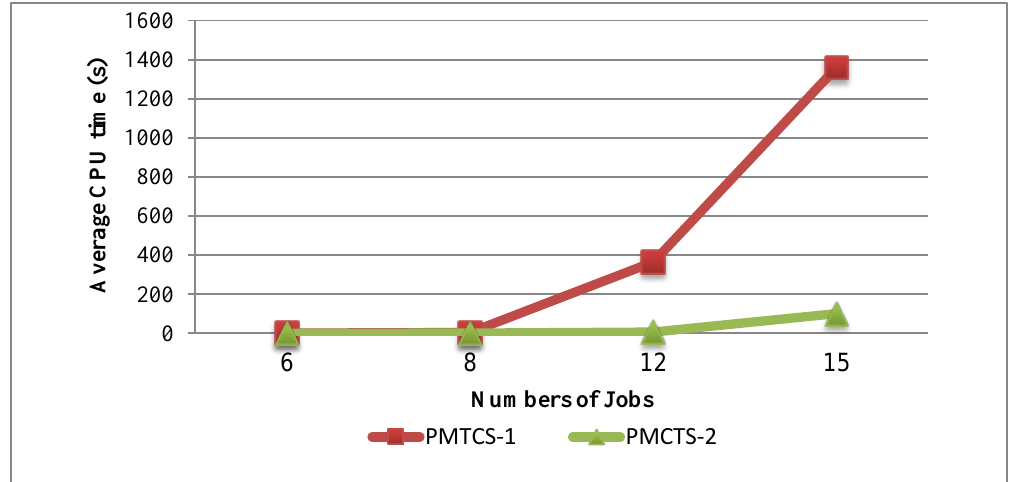
Fig. 3. Average computational times at varying number of jobs for each